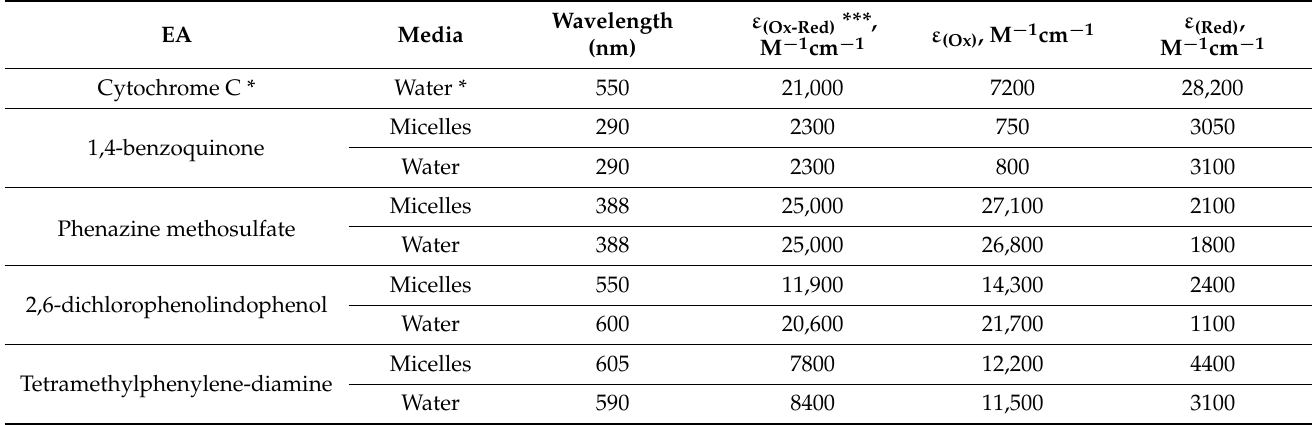
Table 1. Parameters ** of electron acceptors for AtGALDH and 2,6-dichloro-phenolindophenol dye in aqueous (control) and micellar media (aqueous medium was phosphate buffer, pH 8.8, micellar was 0.1 M AOT in n-octane, hydration degree W 0 =